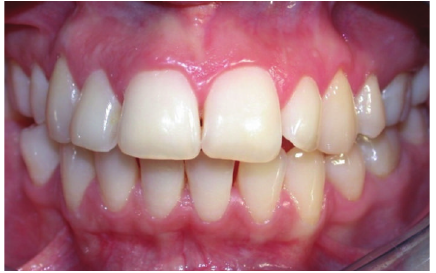
Figure 1: Frontal view.